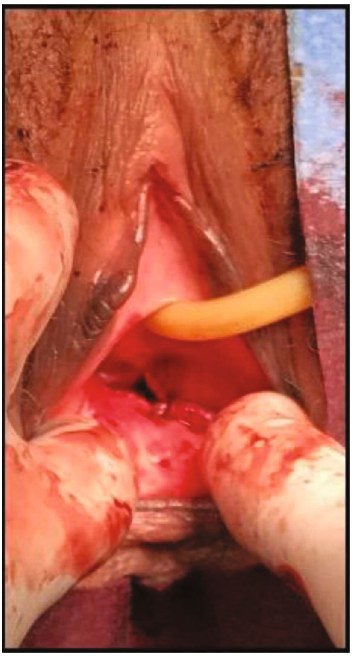
Figure 3: Primary closure of open vaginal wall injury.